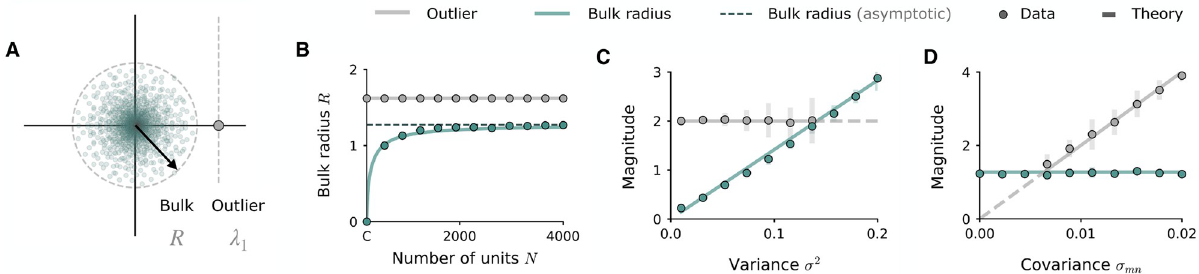
Fig 3. Key features of rank-one eigenspectrum become independent of N in the high sparsity limit. A : Illustration of the spectral radius R of the bulk distribution induced by sparsity, and the outlier λ 1 inherited from the rank-one structure. Dots: eigenvalues of matrix. Dashed lines: theoretical predictions, with C = 200, N = 2000, σ 2 = 0.09, and σ = 0.008. B : Bulk radius (Eq 14) as a function of sparsity imposed by fixing C = 200 and mn increasing N , for the rescaled matrix P = m with σ 2 = 0.09 and σ = 0.008. The outlier Cσ is now independent of N . The bulk radius converges ij i n j mn mn ffiffiffiffi p towards s 2 (dashed line) as sparsity increases. C : Outlier and bulk radius as a function of the variance of the connectivity vectors, while the C covariance is fixed ( σ mn = 0.01). D : Outlier and bulk radius as a function of the covariance σ mn , while the variance is fixed ( σ 2 = 0.09). Empirical values are displayed as mean (dots) and standard deviation (bars, 10 repeats) of the eigenvalue with largest absolute magnitude (bulk) and real part (outlier), while the outlier is still distinguished from the bulk. When the outlier is smaller than the bulk, its location cannot be measured empirically. Lines: theoretical predictions at empirically measurable (solid) and unmeasurable (dashed) locations. Parameters: C = 200, N = 1200, resulting in s = 0.8.